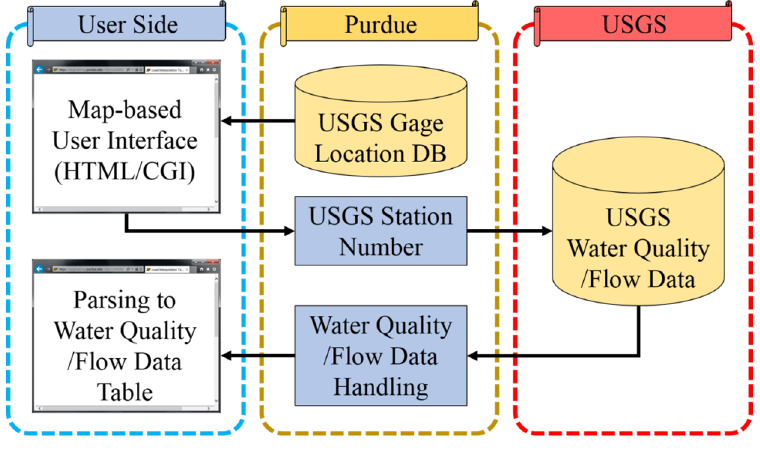
Figure 2 . Schematic depicting web-based tool access of water quality data from USGS